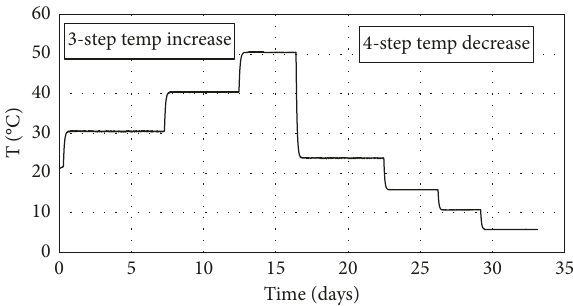
Figure 1: Stepwise temperature regime during the experiment obtained from the sensor at midlocation of mix